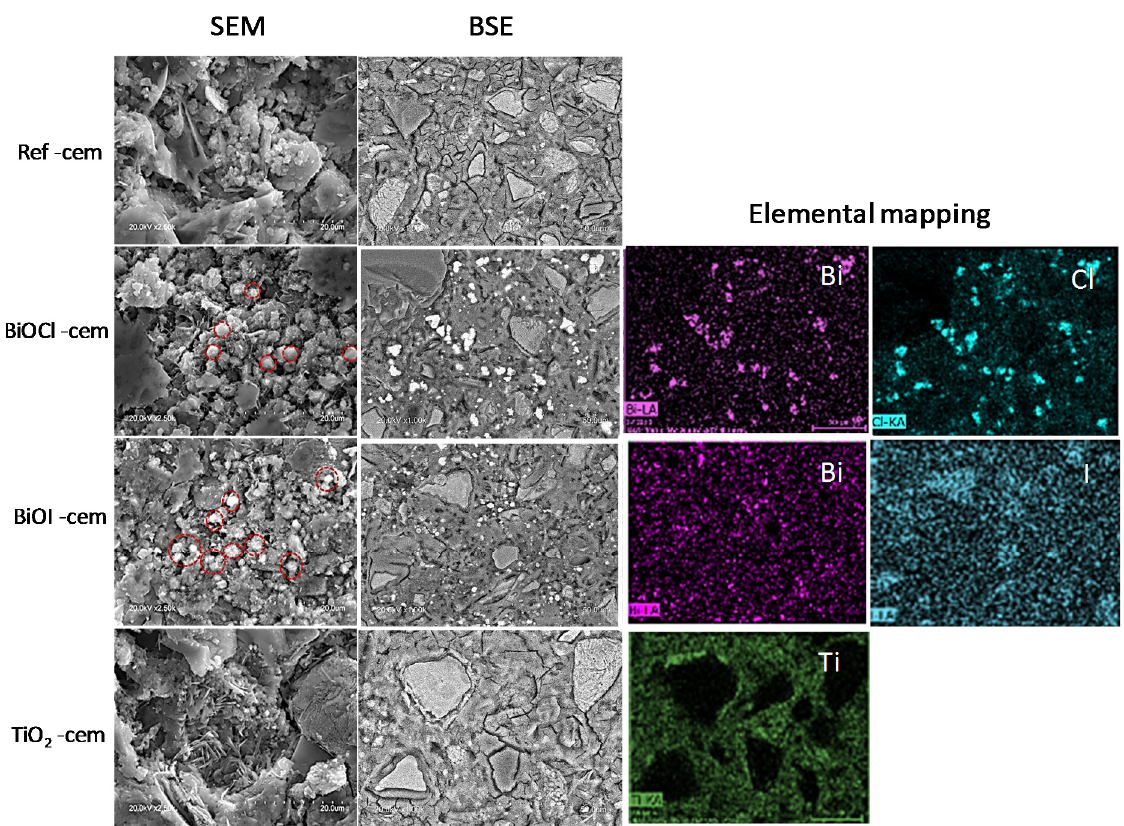
Figure 8. SEM, BSE, and the corresponding elemental mapping images of reference and photocatalytic mortars at the age of 28 days. Red circles in SEM images corresponding with BiOX particles.